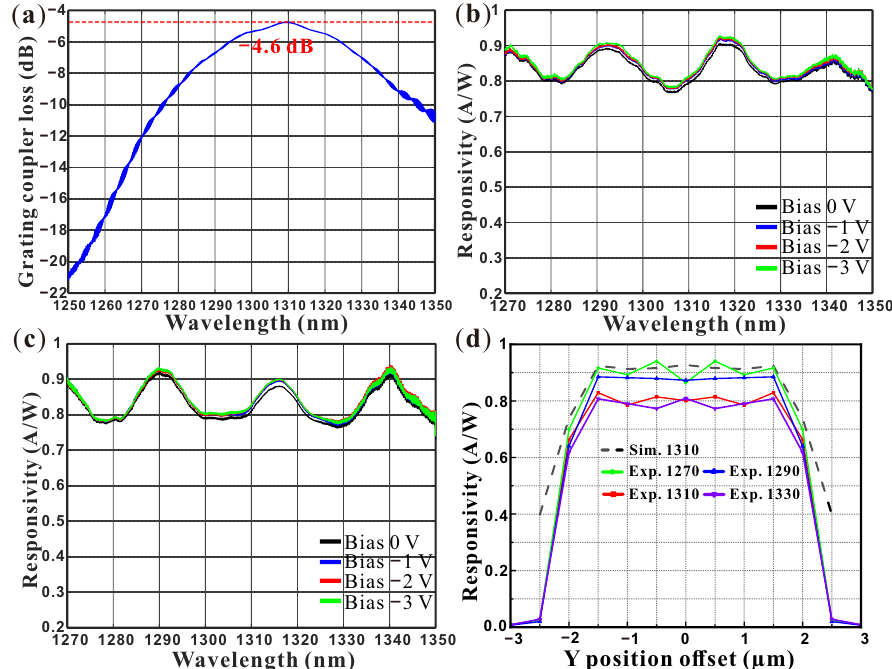
Figure 7. ( a ) Loss of grating coupler from 1250 to 1350 nm. Responsivity spectrum of the MM-PD ( b ) and T-PD ( c ) from 1270 to 1350 nm at different biases. ( d ) Responsivity for different Y-position offsets of the excitation source: the dashed line is the simulated result at 1310 nm, and the green, blue, red, and purple solid lines are the experimental results,